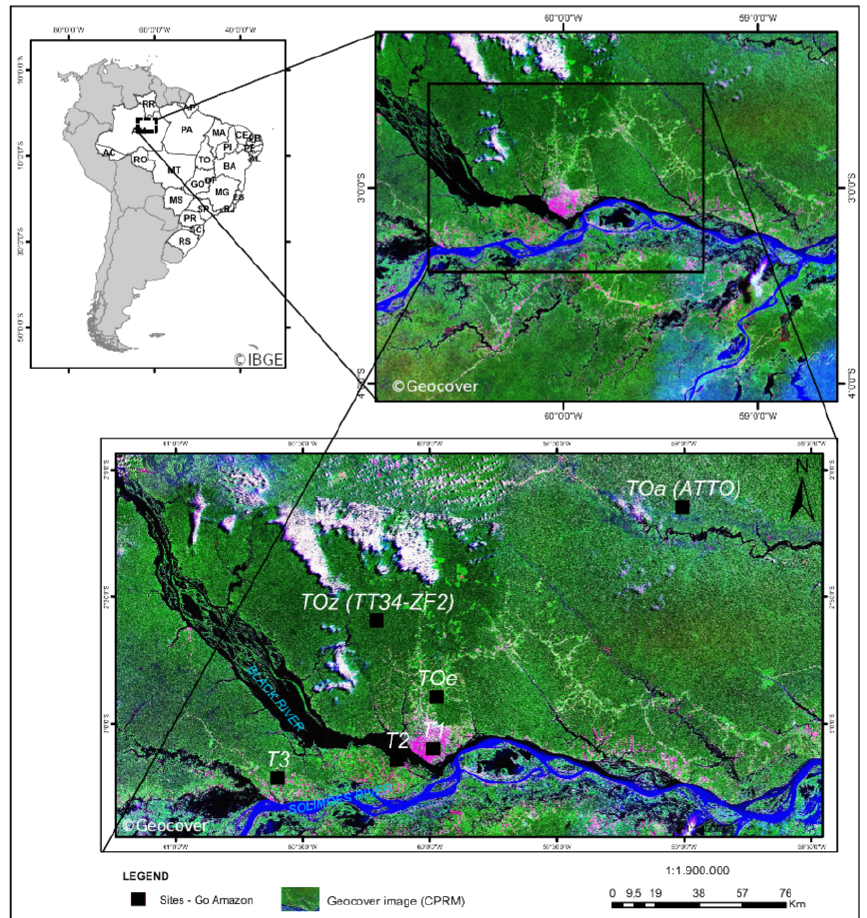
Figure 1. Map of the GoAmazon field campaign instrumented sites. Measurements used in this work came from the T3 site. © Geocover, ©